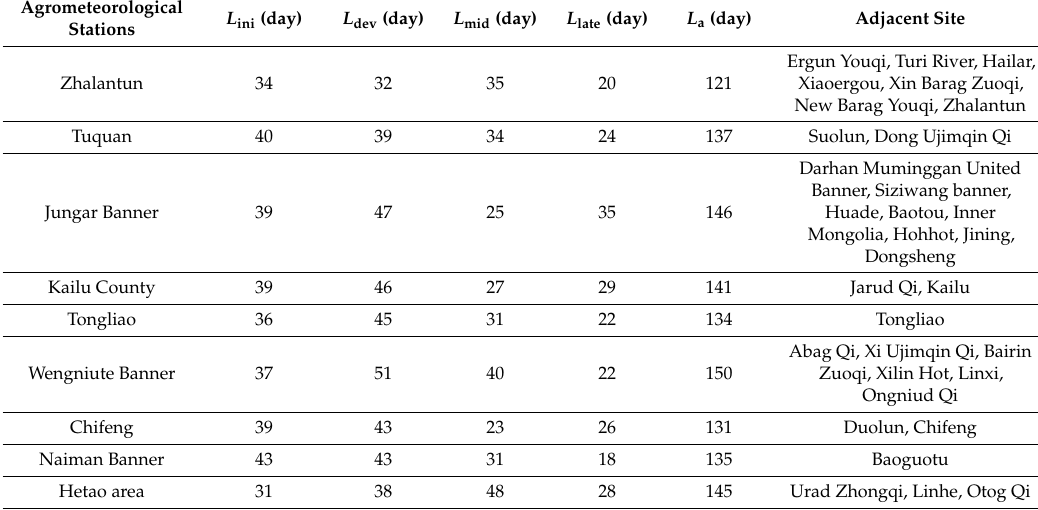
Table 1. Duration of each growth period of maize and names of adjacent weather stations in each agrometeorological station from 1991 to 2008.